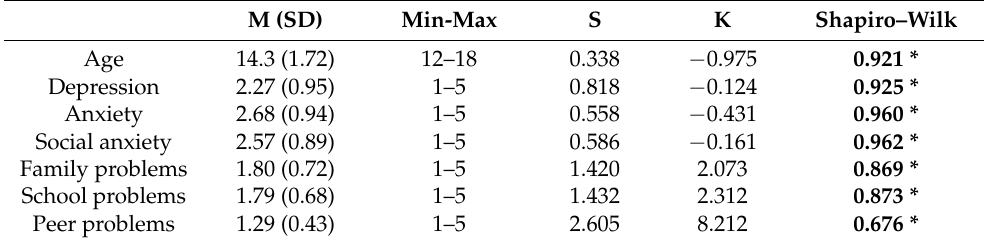
Table 2. Descriptive statistics.